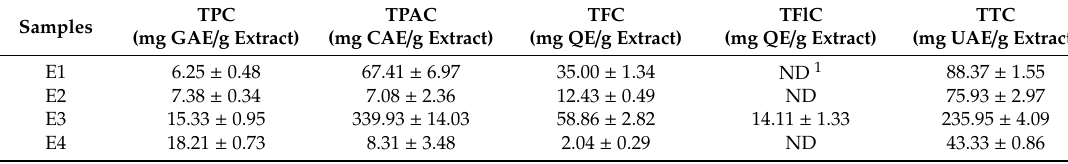
Table 2. Chemical characterization of Hypnum cupressiforme